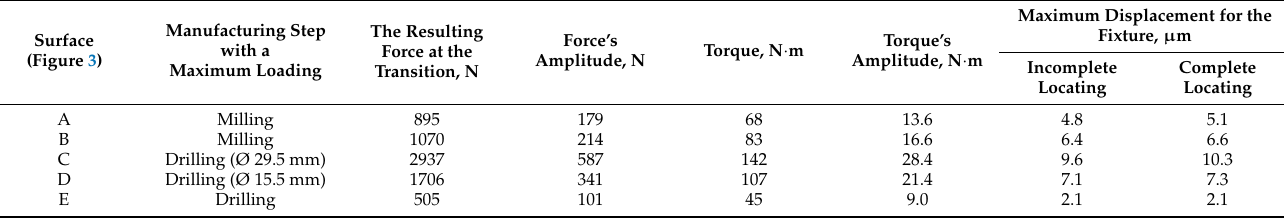
Table 5. The results of the dynamic analysis.